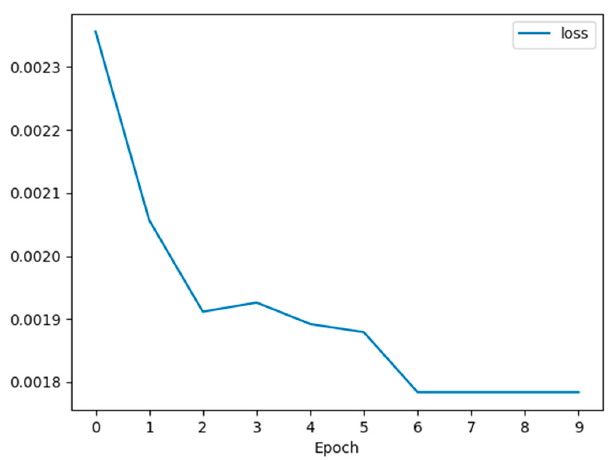
Figure 5. Adaptability values of the SSA for the IEEE118-bus test system.